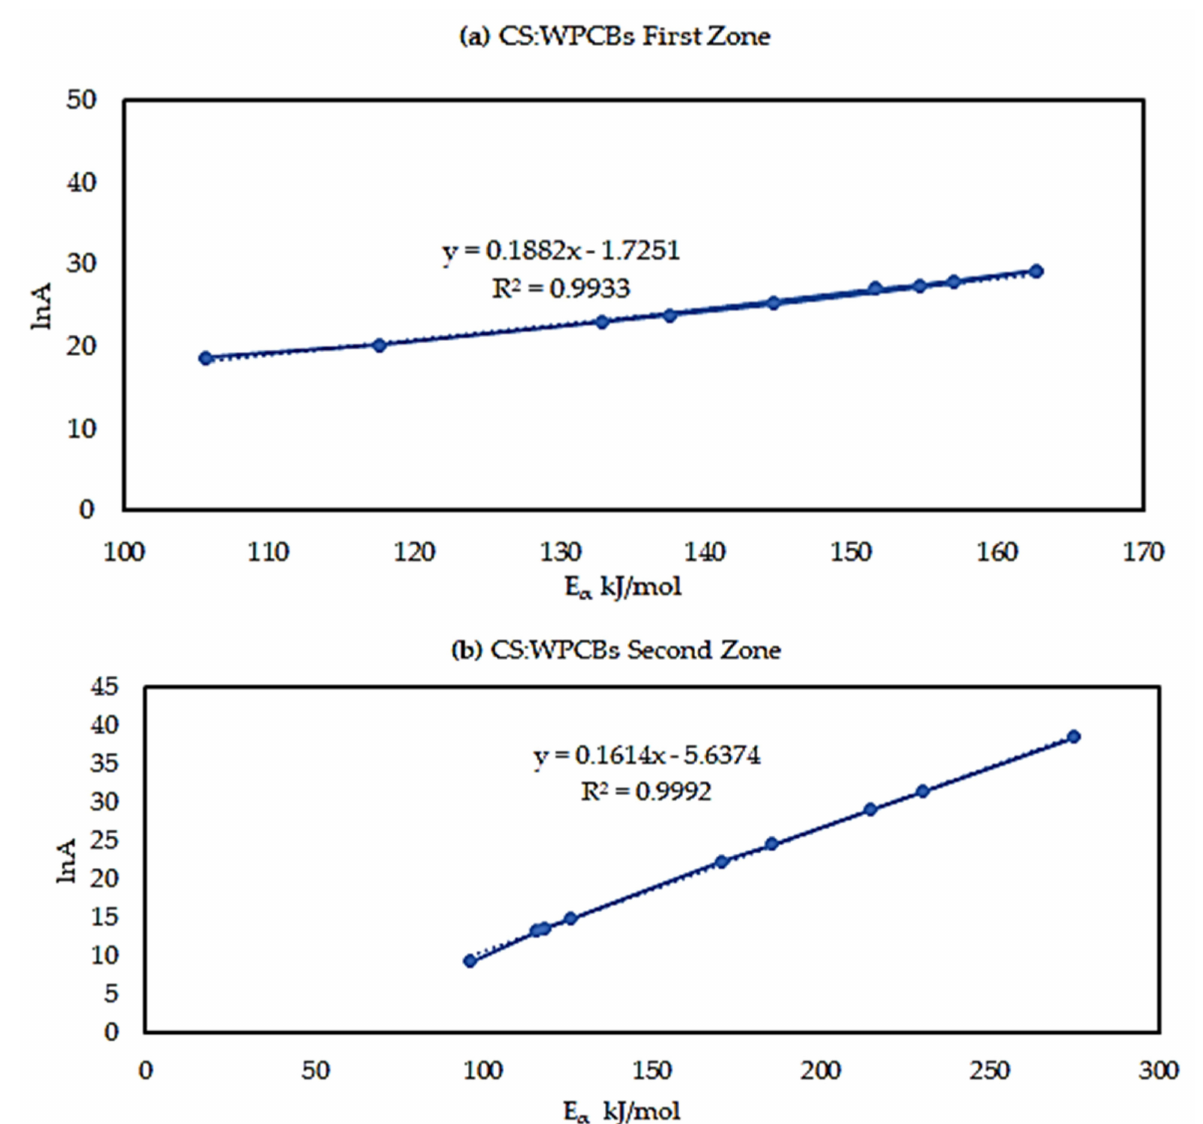
Figure 8. Compensation effect between A and E α for CS-WPCBs with ( a ) first zone and ( b ) second